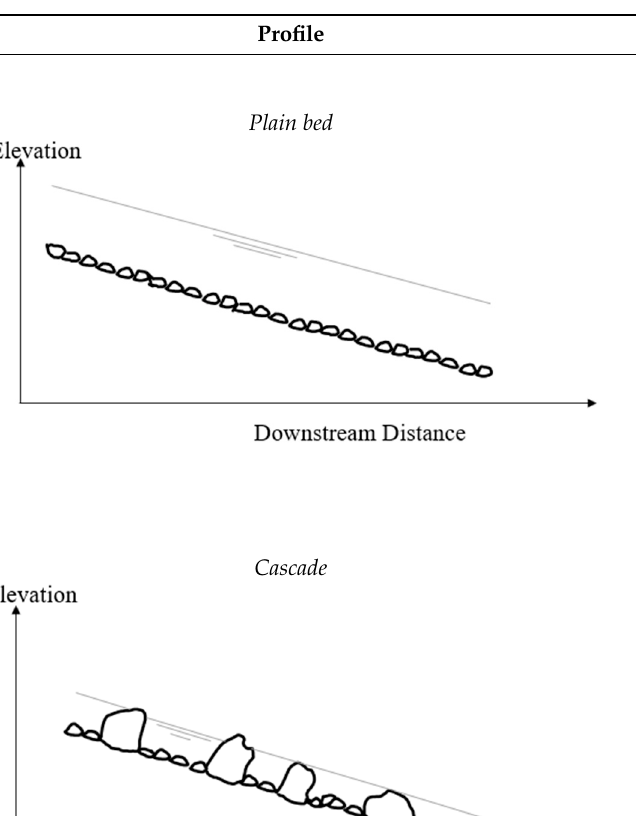
Table 1. Longitudinal profiles and pictures of Cascade , Step-pool , and Plane-bed .